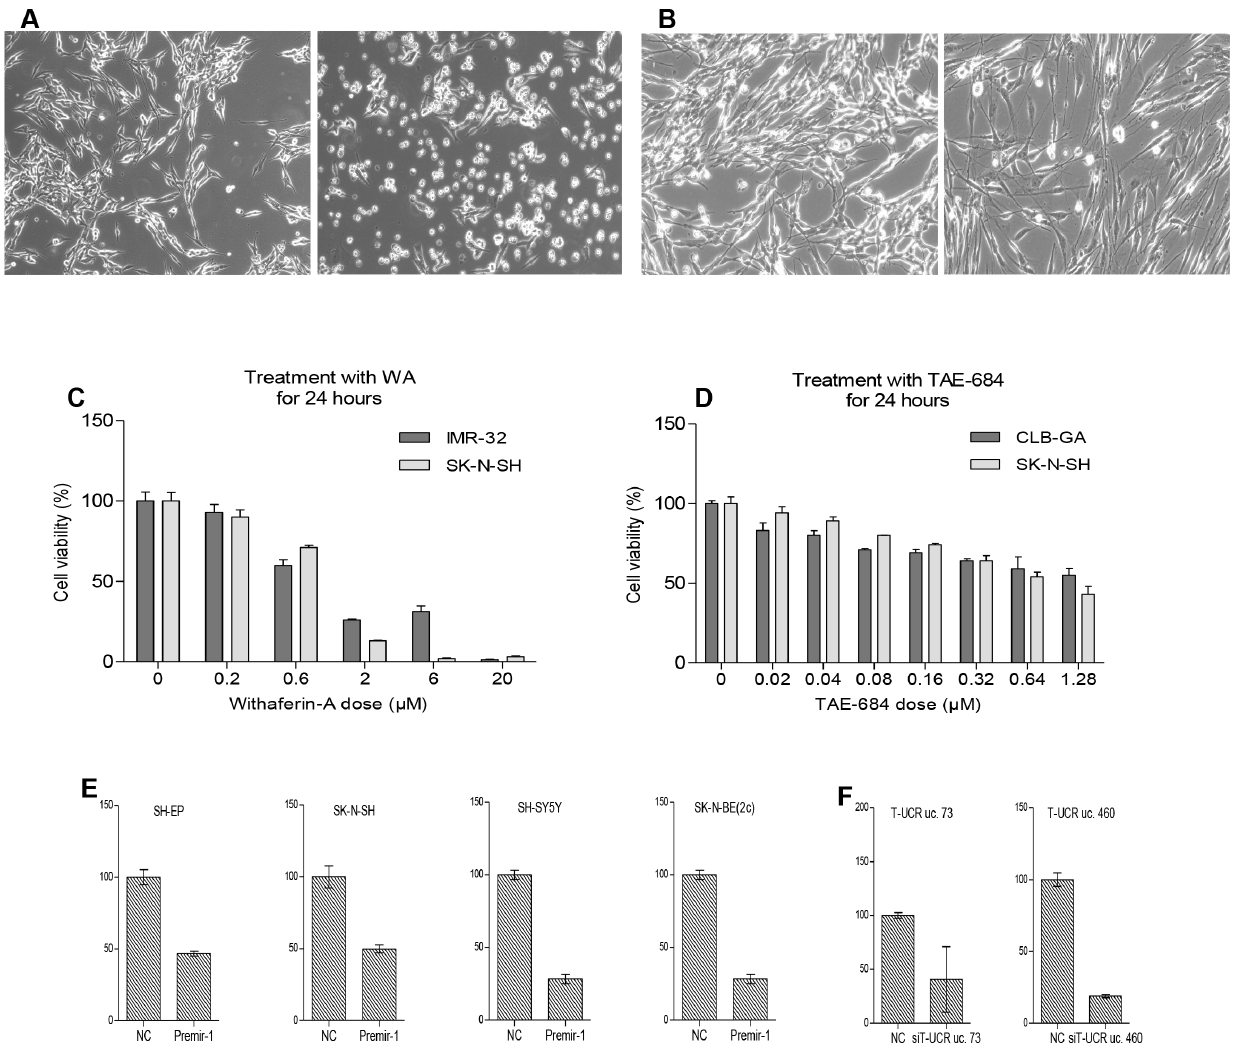
Figure 1. Various treatments of neuroblastoma cells. (A), nutlin-3 treated NGP cells, 16 m M (right) and vehicle control (left). (B), ATRA treated NGP cells with elongated neurites (right) and vehicle control (left). (C), cell viability assay of IMR-32 and SK-N-SH cells after treatment with increasing concentrations of withaferin-A for 24 hours. Error bars, SD (n=3). (D), cell viability assay after treatment of CLB-GA and SK-N-SH cells with increasing concentrations of TAE-684 for 24 hours. Error bars, SD (n=3). (E), RT-qPCR expression data of PTK9 in SH-EP, SK-N-SH, SH-SY5Y and SK-N-BE(2c) after transfection with miR-1 mimic or scrambled miRNA mimic serving as a negative control (NC). Error bars, SEM (n=2). (F), RT-qPCR expression data of T- UCR uc. 73 (left) and T-UCR uc.460 (right) 24 hours after transfection of SH-EP cells with siRNA against T-UCR uc. 73 and siRNA against T-UCR uc. 460 respectively. Errors bars, SEM (n=2).